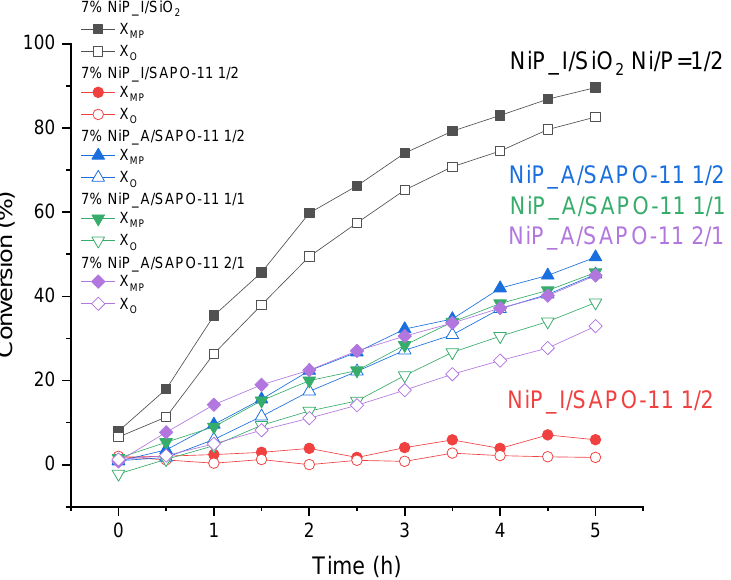
Figure 3. Conversion of MP and O-containing compounds over 7 wt.% NiP_I/SiO 2 , NiP_A/SAPO-11 with different Ni/P ratios, and NiP_I/SAPO-11 in an autoclave (290 ◦ C, 3 MPa, V H2 = 100 mL/min, 500 RPM, m cat = 1